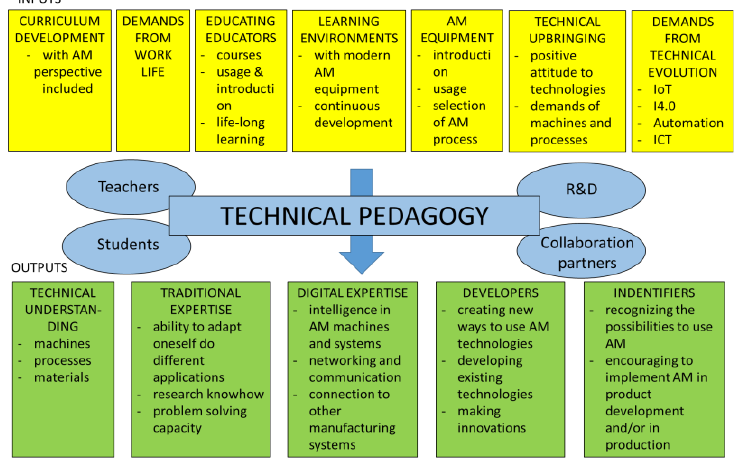
Fig. 11. The model of technical